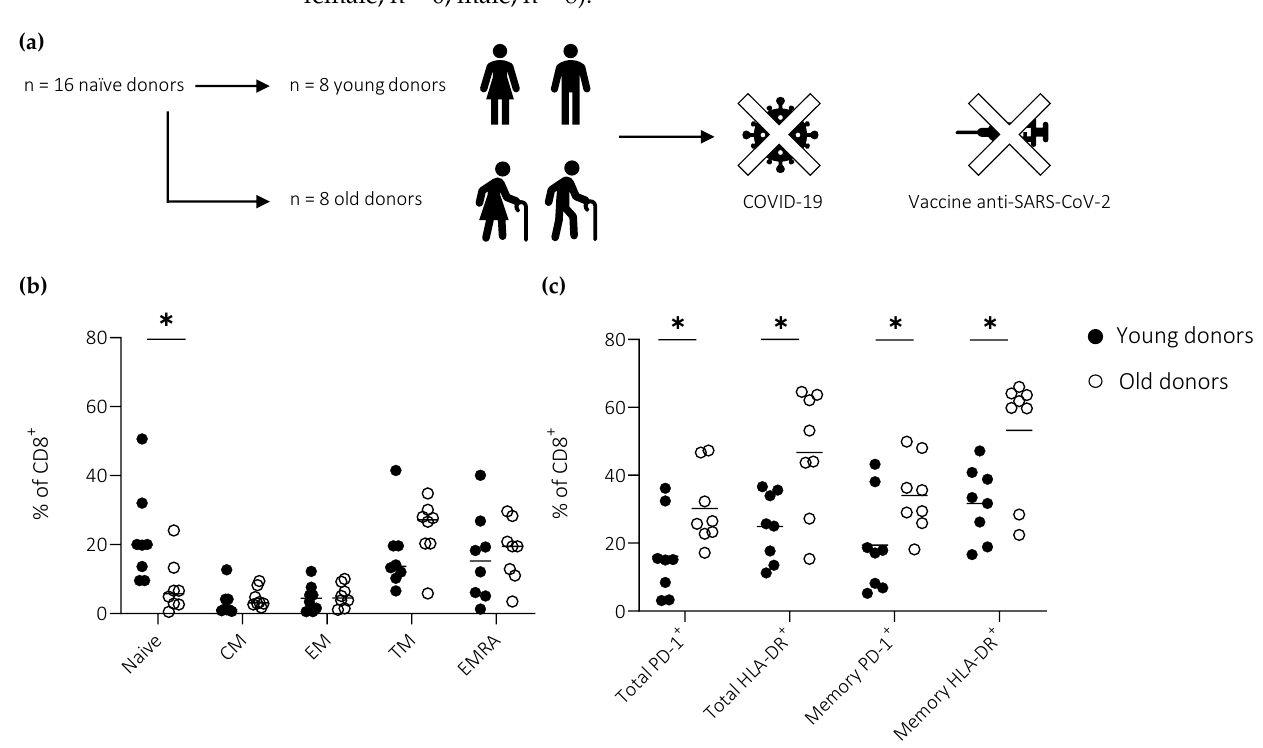
Figure 1. Activation and differentiation in the peripheral CD8 + T cell compartment as a function of age. ( a ) Donors were stratified according to age. ( b ) Frequencies of naïve (CCR7 + CD27 + CD45RA + ), central memory (CM; CCR7 + CD27 + CD45RA − ), transitional memory (TM; CCR7 − CD27 + CD45RA − ), effector memory (EM; CCR7 − CD27 − CD45RA − ), and terminally differentiated EM (EMRA; CCR7 − CD27 − CD45RA + ) CD8 + T cells. ( c ) Expression frequencies of HLA-DR and PD-1 among total (including naïve) and memory (excluding naïve) CD8 + T cells. ( b , c ) Horizontal lines represent median values. * p < 0.05 (Mann–Whitney U